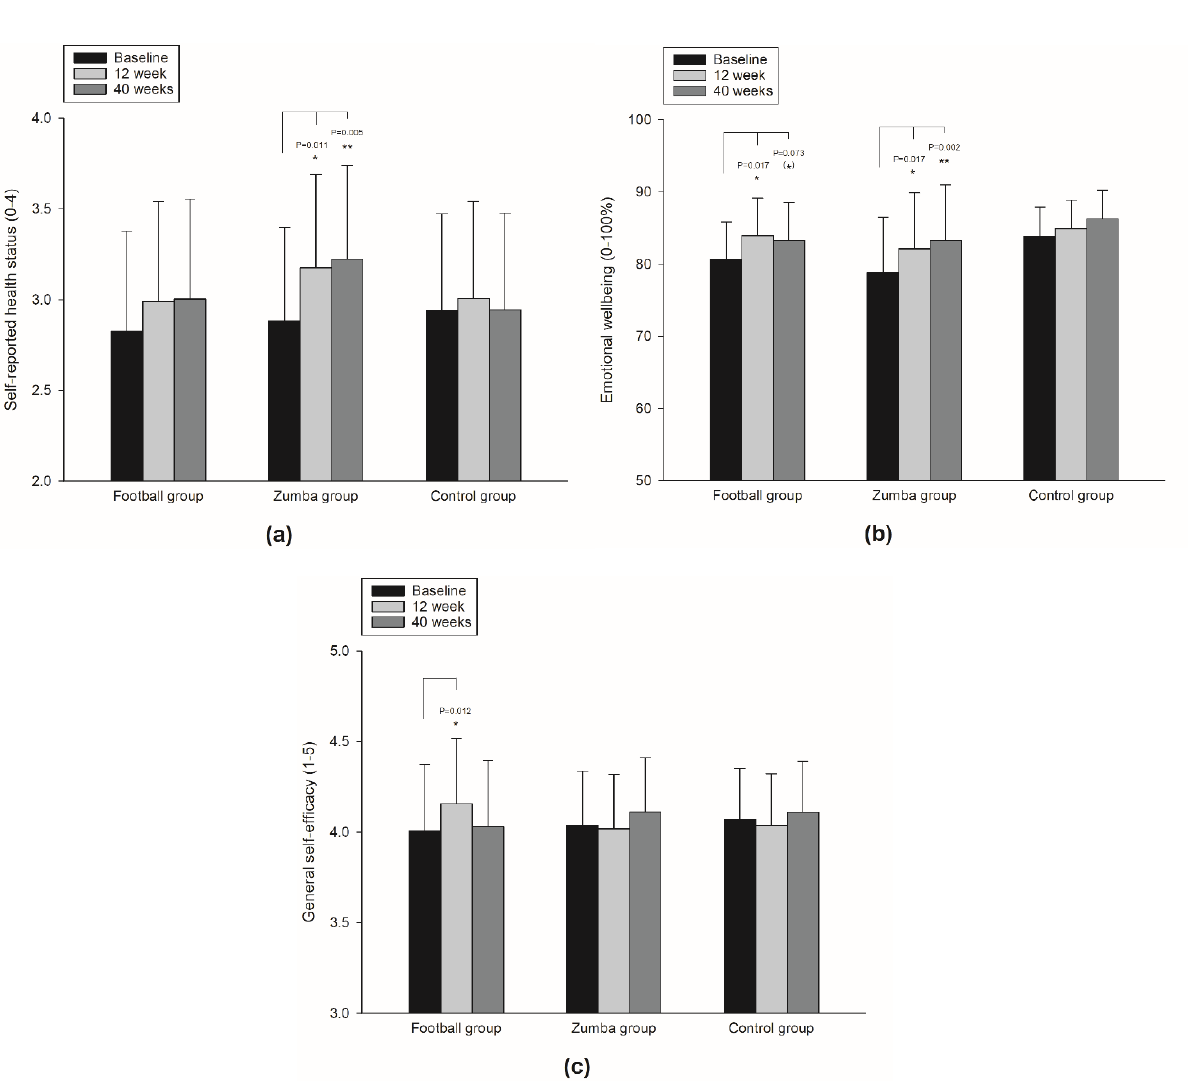
Figure 3. Within-group changes over 12 and 40 weeks in self-reported health status ( a ); emotional wellbeing ( b ); and general self-efficacy ( c ). Significant within-group change denotes; ** ( p < 0.01), * ( p < 0.05), ( * ) ( p < 0.1) tendency for